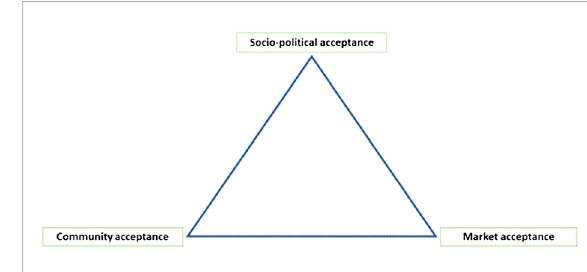
FIGURE 1 Thetriangleofsocialacceptance.Source:Wüstenhagenetal.